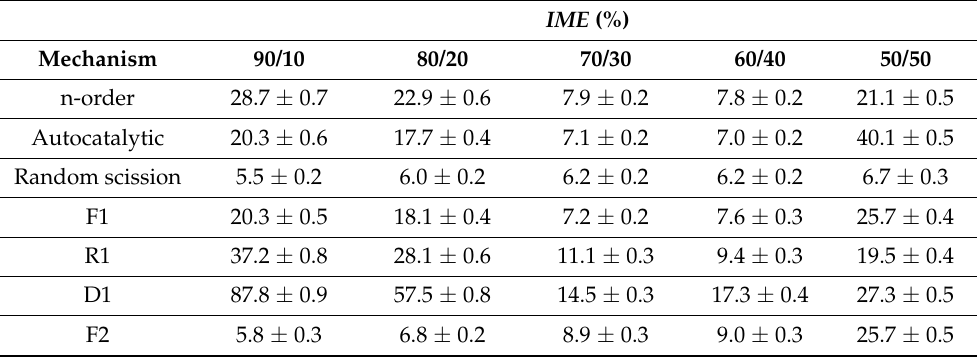
Table 4. Integral mean error ( IME ) between experimental and theoretical data of f ( α )/ f ( α r ) for various mechanisms for the thermal degradation of PLA for bioblends containing from 50% to 90% PLA.